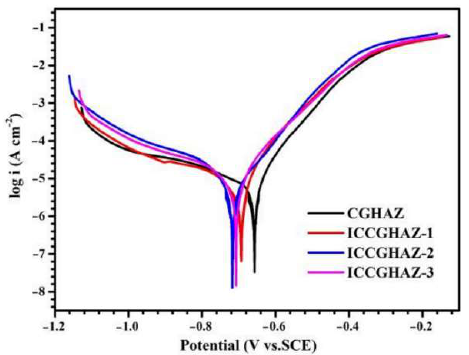
Figure 10. Potentiodynamic polarization curves of the CGHAZ and ICCGHAZs with different secondary peak temperatures in 3.5 wt% NaCl solution.